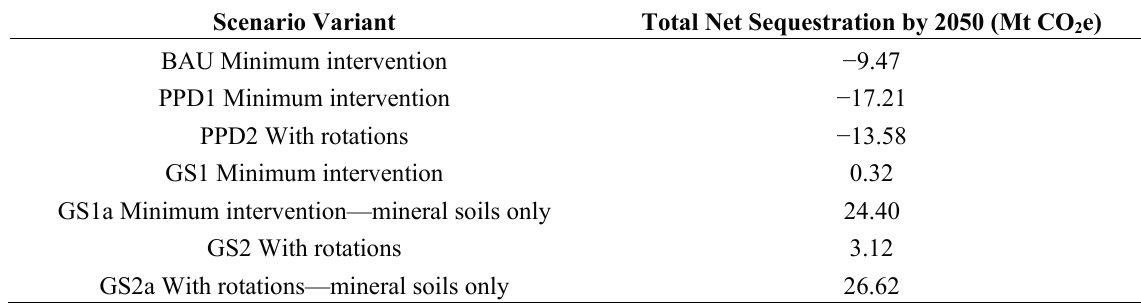
Table 5. Total net sequestration values by 2050 for each scenario variant.